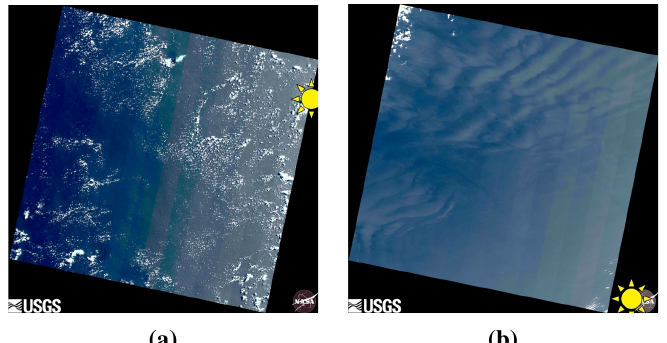
Figure 8. Sample ocean scenes where FPM-to-FPM discontinuities are visible due to view angle differences between forward and aft viewing FPMs. In image ( a ), the sun is directly above the Earth’s surface on the upper right while in image ( b ) the sun is directly above the Earth’s surface on the lower right.